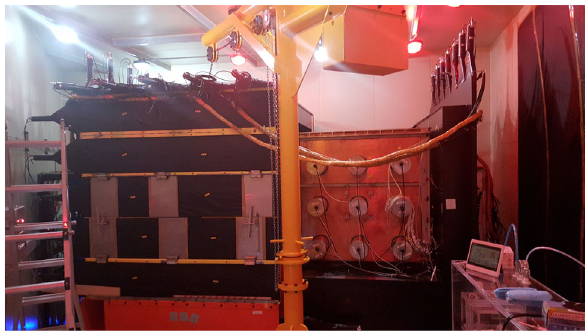
Fig. 2 Photo of the COSINE detector with the front side open. Plastic scintillators with black covers and an orange copper box with 5-inch PMTassembliesareshown.Ahoistisusedtomovethe800kgtopcover of the copper